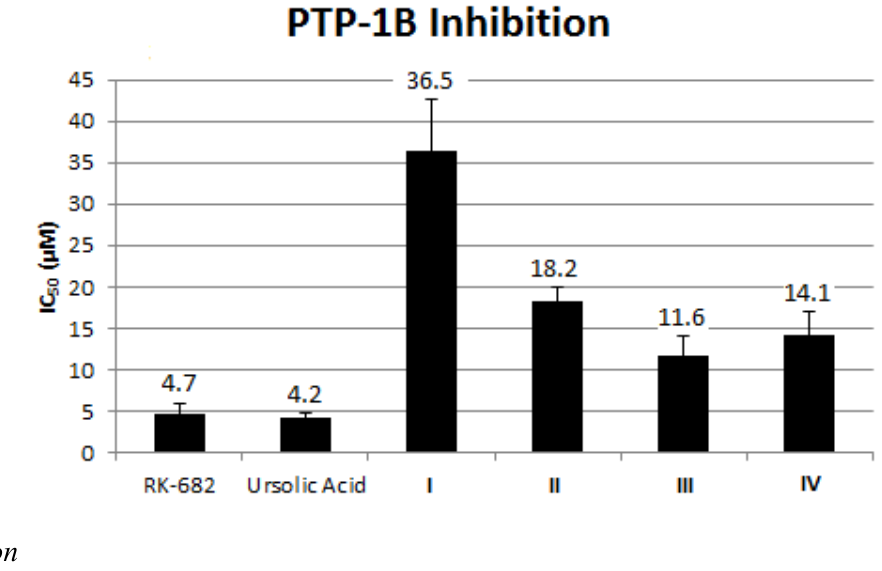
Figure 6. PTP-1B inhibition of isolated alkaloids I – IV compare against the positive control drugs RK-682 and ursolic